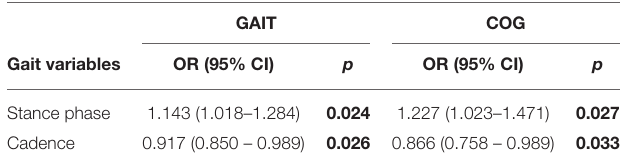
TABLE 3 | Gait variables distinguishing PSP phenotypes according with the multinomial logistic regression.